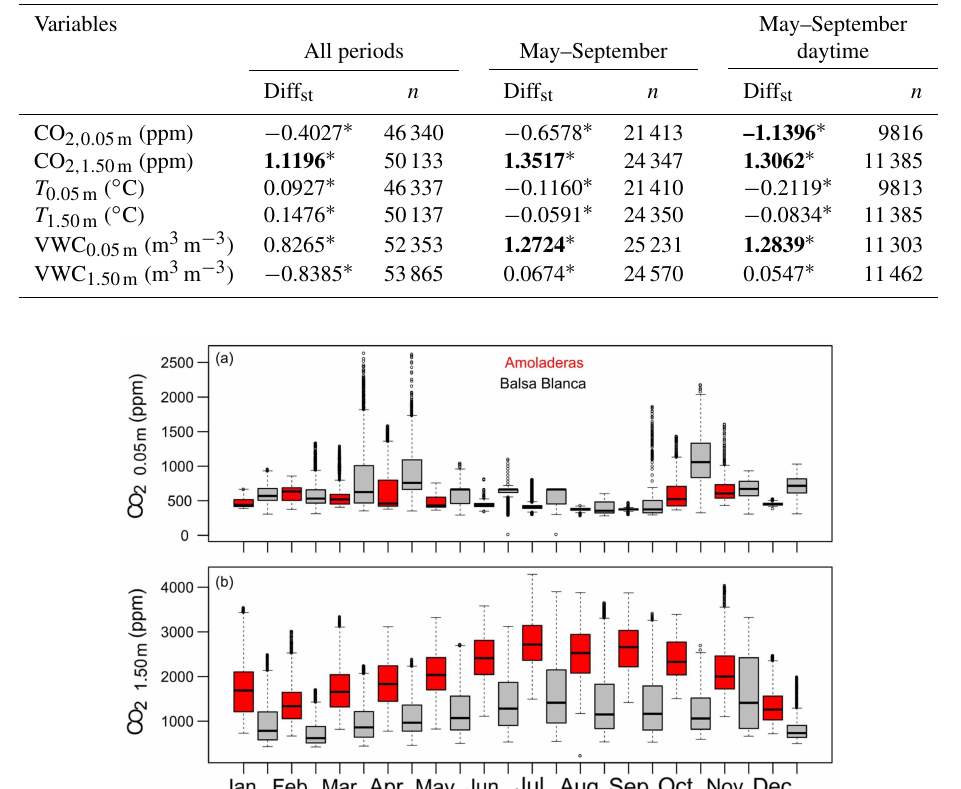
Figure 8. Box-and-whisker plots of CO 2 molar fractions measured at (a) 0.05m and (b) 1.50m belowground in Amoladeras (red boxes) and Balsa Blanca (grey boxes) from January 2014 to August 2015. The box extends from the first ( Q 1 ) to the third quartiles ( Q 3 ) and the central line represents the median (50% percentile). Dots represent outliers; the upper whisker is located at the smaller of the maximum value and Q 3 + 1.5 IQR (interquartile range), and the lower whisker is located at the larger of the minimum value and Q 1 − 1.5